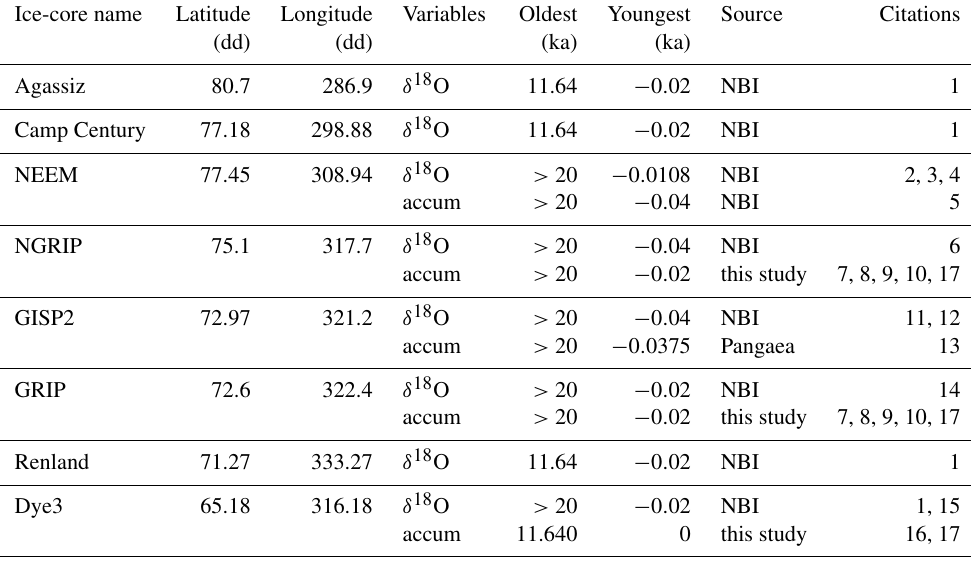
Table 1. Metadata for the water isotope ( δ 18 O) and accumulation (accum) records referenced in this study. “NBI” refers to the Niels Bohr Institute data access site (http://www.iceandclimate.nbi.ku.dk/data/, last access: 24 June 2019) and “Pangaea” refers to the Pangaea data access site (https://www.pangaea.de/, last access: 20 August 2019). Latitude and longitude are in units of decimal degrees (dd) and dates are in thousands of years before 1950 CE (ka).